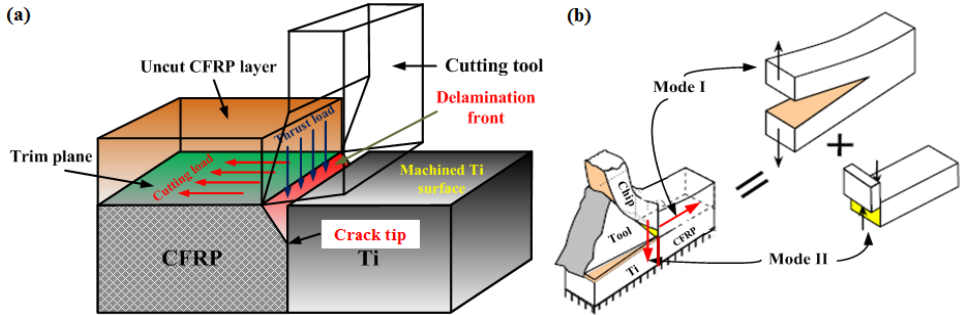
Figure 9. Scheme of ( a ) crack path in interface region and ( b ) fracture modes I and II in cutting. To specify the dynamic process of delamination formation and also the affected interface zone (AIZ), nine interface nodes beneath the trimmed plane were selected to characterize their X -direction displacement versus cutting time ( t ) as shown in Figure 10. Table 8 summarizes the depth beneath the trim plane of the selected interface nodes. The AIZ studied here was devoted to clarifying the actual cutting time that influenced the interface damage formation during the orthogonal cutting